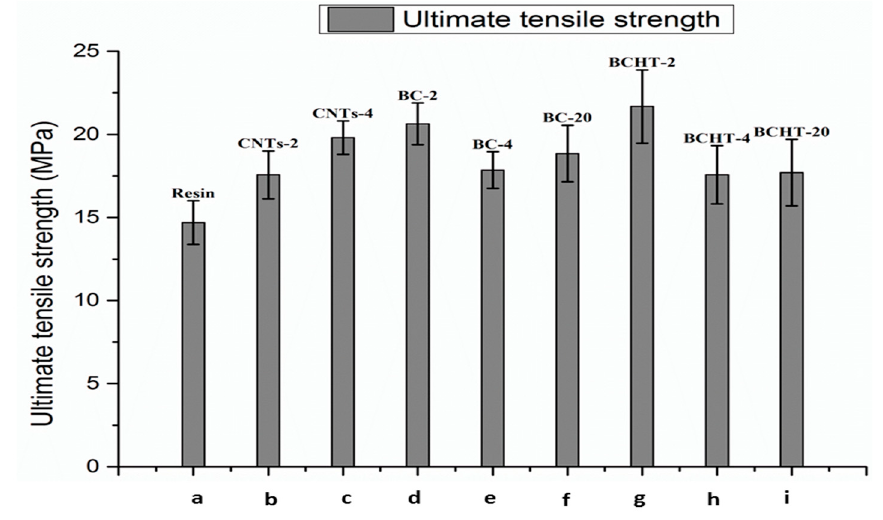
Figure 7. Ultimate tensile strength comparison. ( a ) Neat epoxy; ( b ) MWCNTs 2 wt %; ( c ) MWCNTs 4 wt %; ( d ) biochar 2 wt %; ( e ) biochar 4 wt %; ( f ) biochar 20 wt %; ( g ) biochar HT 2 wt %; ( h ) biochar HT 4 wt %; ( i ) biochar HT 20 wt %.